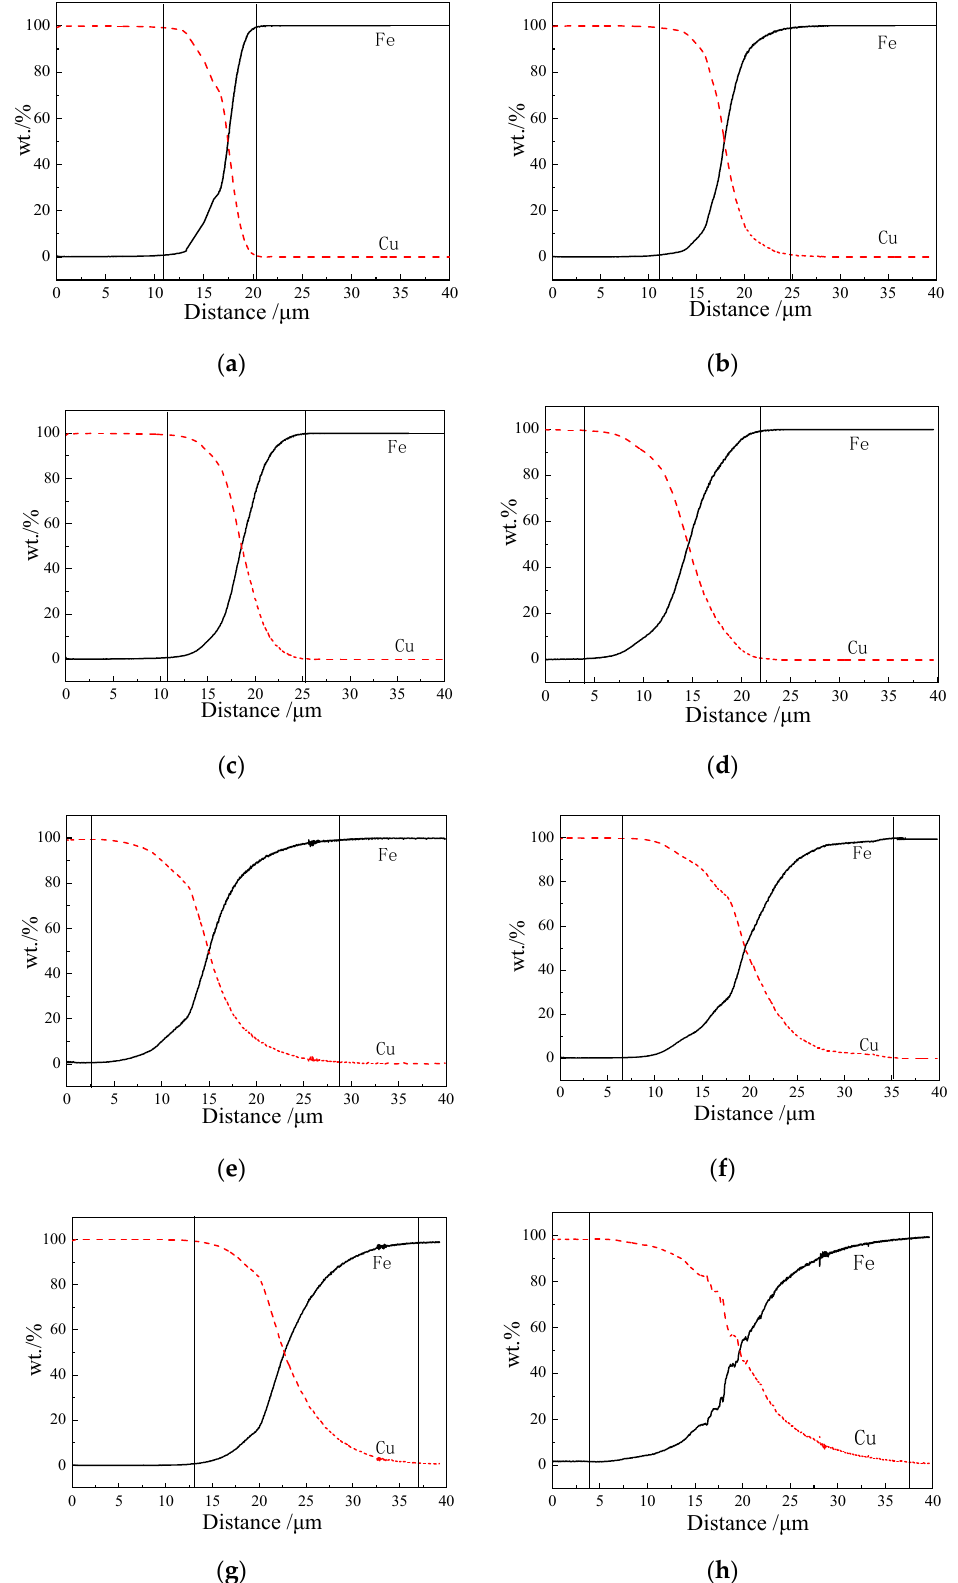
Figure 6. The molar concentration distribution of Cu and Fe in samples at different diffusion annealing temperatures; ( a ) 750 ◦ C; ( b ) 800 ◦ C; ( c ) 850 ◦ C; ( d ) 900 ◦ C; ( e ) 950 ◦ C; ( f ) 980 ◦ C; ( g ) 1000 ◦ C; ( h ) 1050 ◦